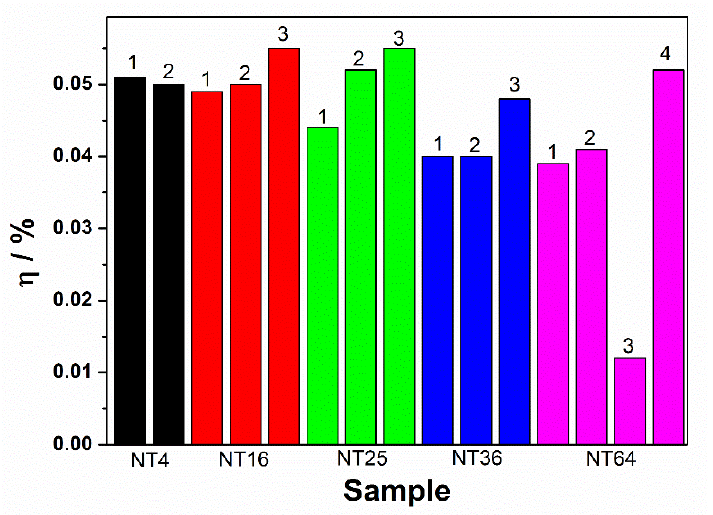
Figure 8. Conversion efficiency values registered for each sample in different places of the elec- trodes.